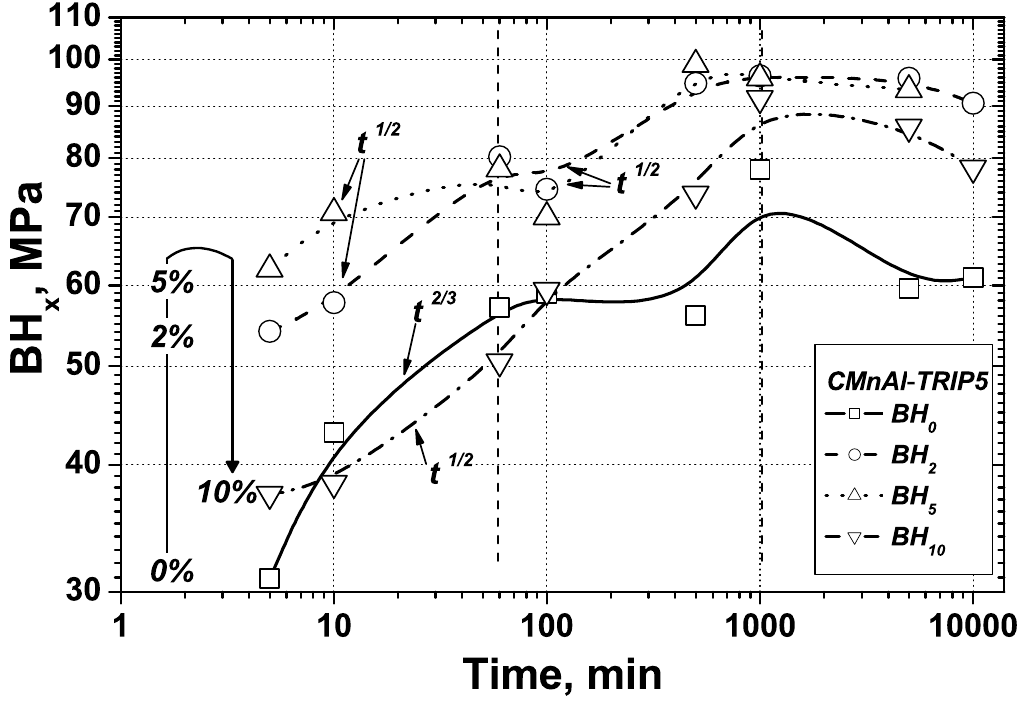
Figure 3. BH kinetics at 170 ◦ C from 5 to 10,000 min for 0%, 2%, 5%, and 5% prestrain for the temper rolled TRIP5 steel.